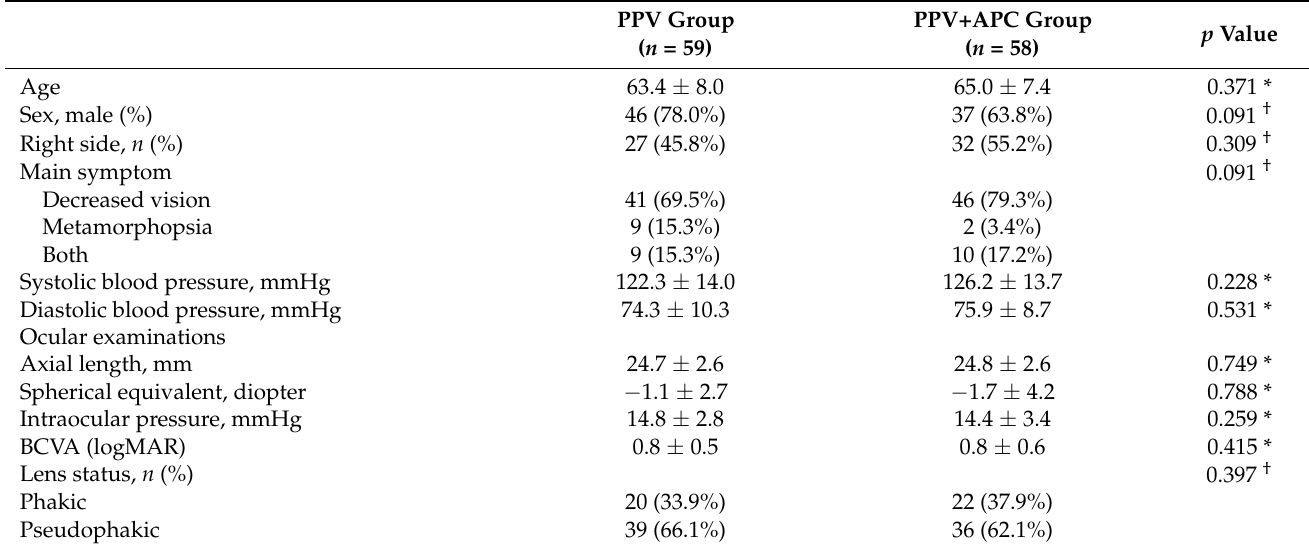
Table 1. Demographics and baseline characteristics.